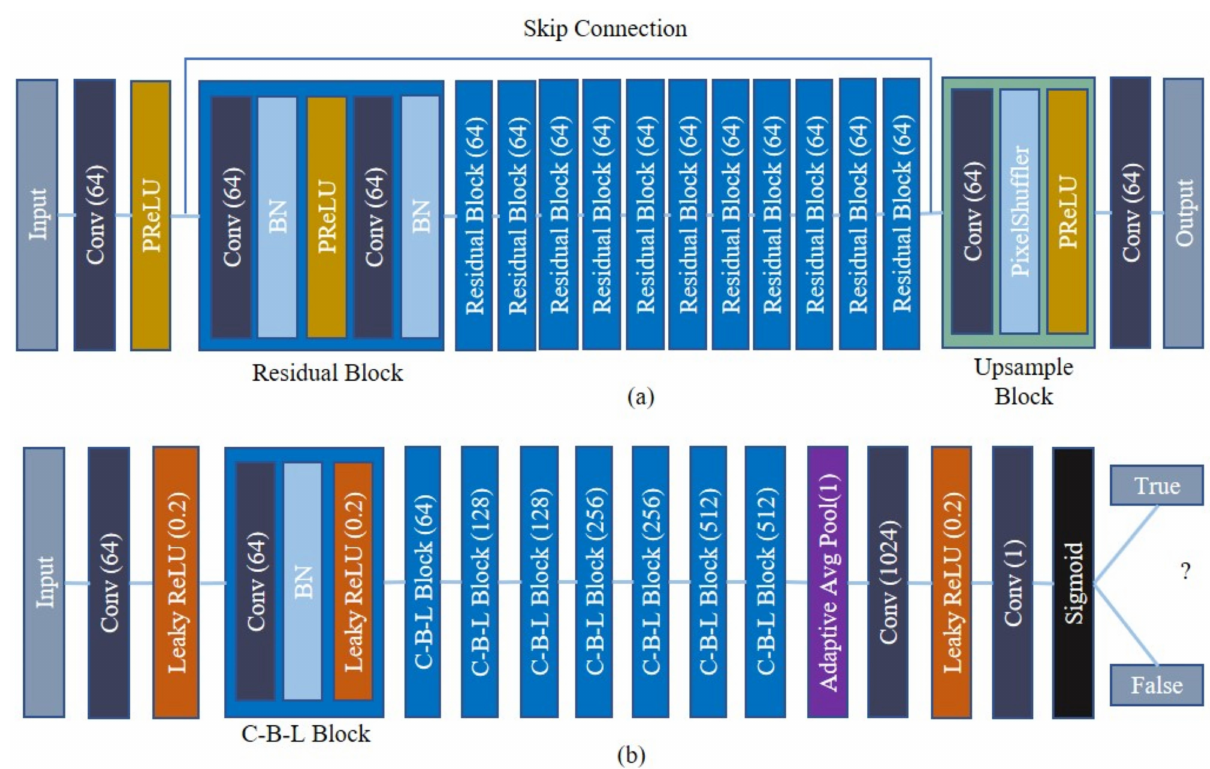
Figure 5. The architecture of the proposed GAN-based resolution enhancement algorithm: ( a ) generator network: the main building block of the network where noise term is used to generate the output; ( b ) discriminator network: discriminate between the generated and the real